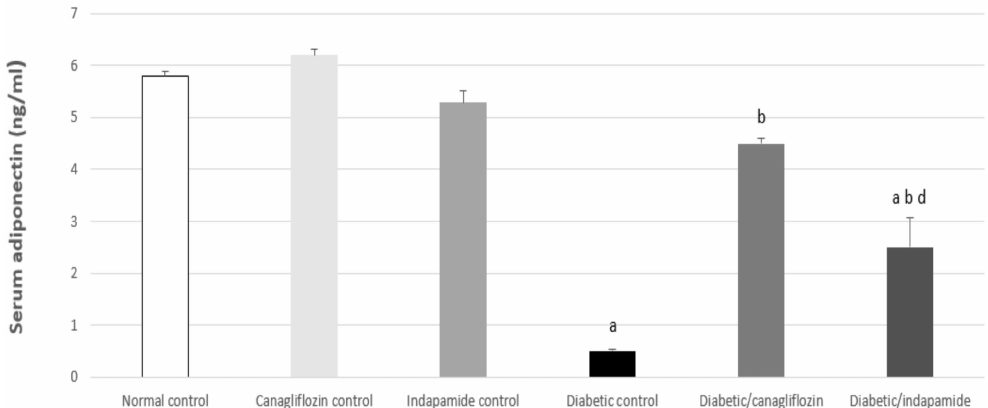
Figure 6. Impact of daily CANA and INDA treatment on serum adiponectin: oral CANA and INDA treatments were initiated once daily for 4 weeks. Data represent the mean ± S.E.M. (6 rats/group). ANOVA followed by post hoc Tukey–Kramer test at ( p < 0.05) was used for statistical comparison; a against normal CTRL, b against diabetic CTRL, d against